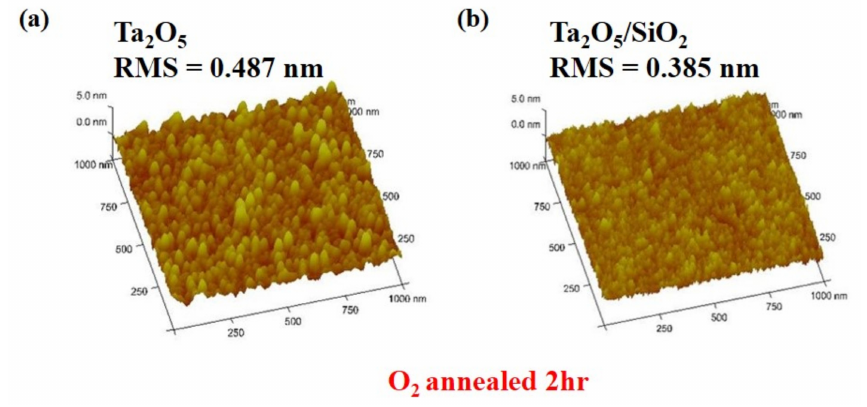
Figure 3. AFM image of: ( a ) the Ta 2 O 5 film and ( b ) the SiO 2 /Ta 2 O 5 film grown on a Si substrate. Because the electric field-induced carrier is confined to a narrow region close to the interface between the gate-insulating film and the channel layer, the characteristics of the interface have a significant influence on the TFT characteristics. The surface of a rough gate-insulating film may result in more grain boundaries [36] or in an increased number of trap states [37]; which may cause surface scattering [38] and reduce the mobility of the carrier.